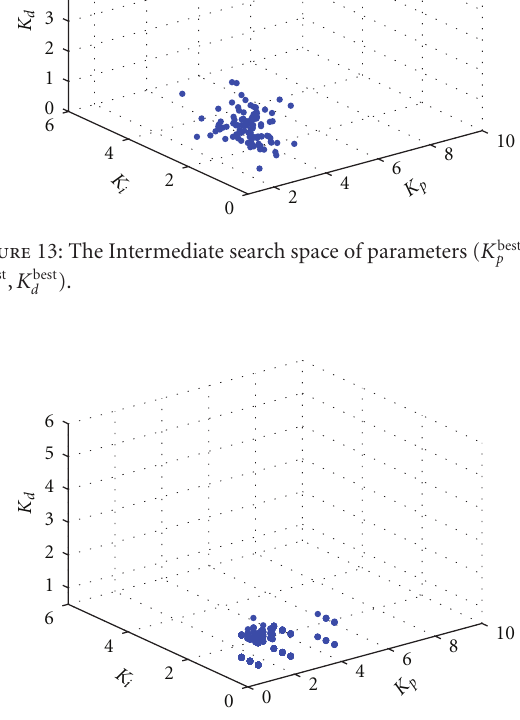
Figure 14: The final search space of parameters ( K opt p , K opt i , K opt d